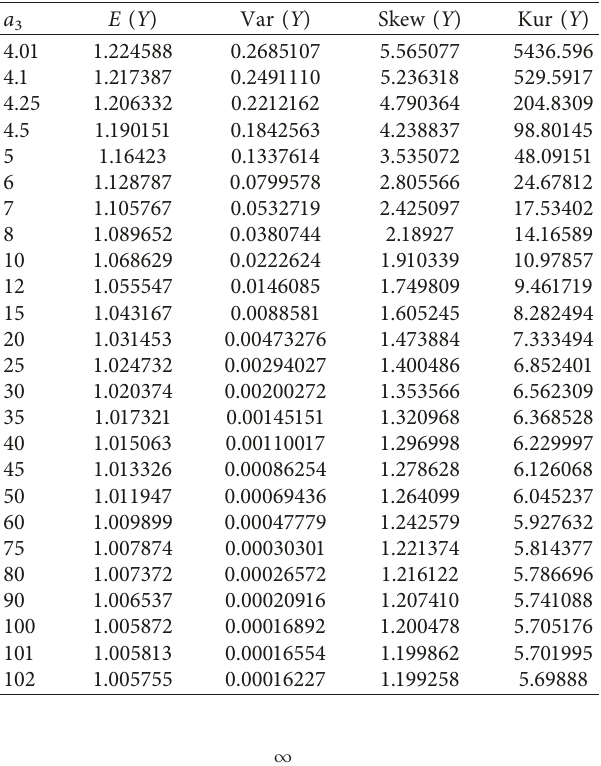
Table 3: E ( X ), Var ( X ), Skew ( Y ), and Kur ( Y ) of the RW model. a 3 E ( Y ) Var ( Y